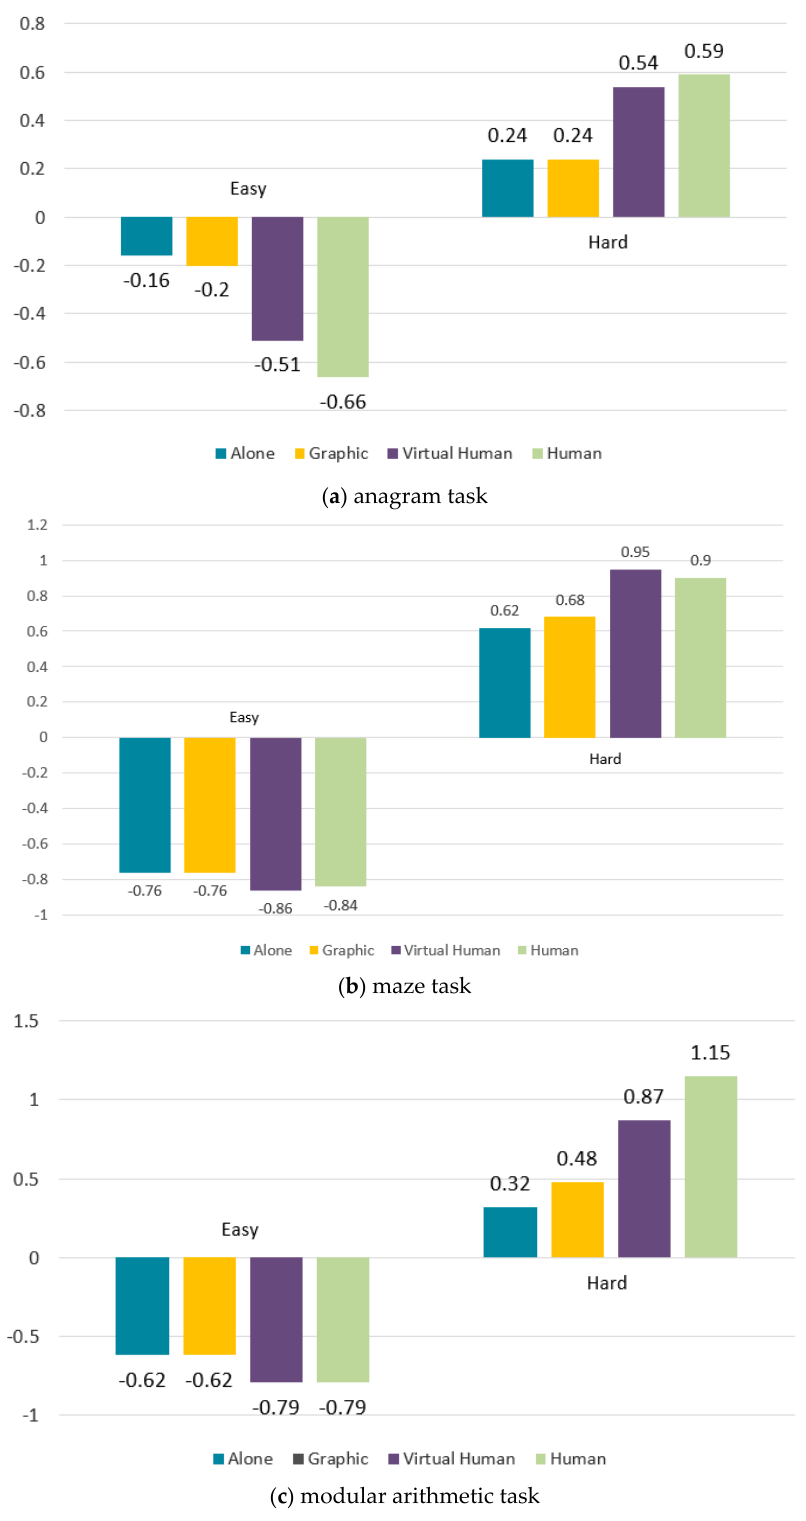
Figure 5. Mean completion time in z-score seconds for each task ( n = 108 each).